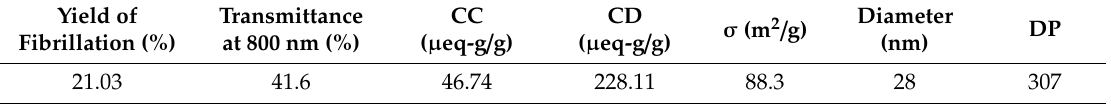
Table 2. Characterization of the obtained lignocellulosic micro / nanofibers (LCMNF). Yield of Transmittance CC Diameter Fibrillation (%) at 800 nm (%) (µeq-g/g) 41.6 46.74 307